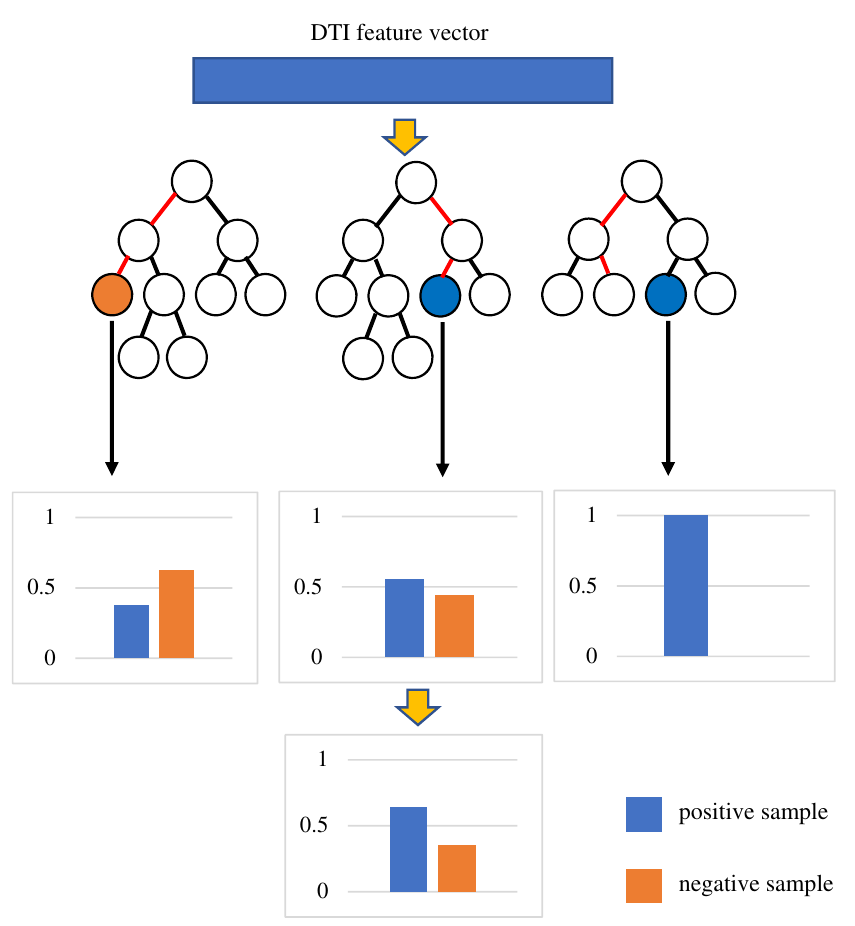
Figure 3. Computing the probability that a feature is classified as positive (or negative) sample.